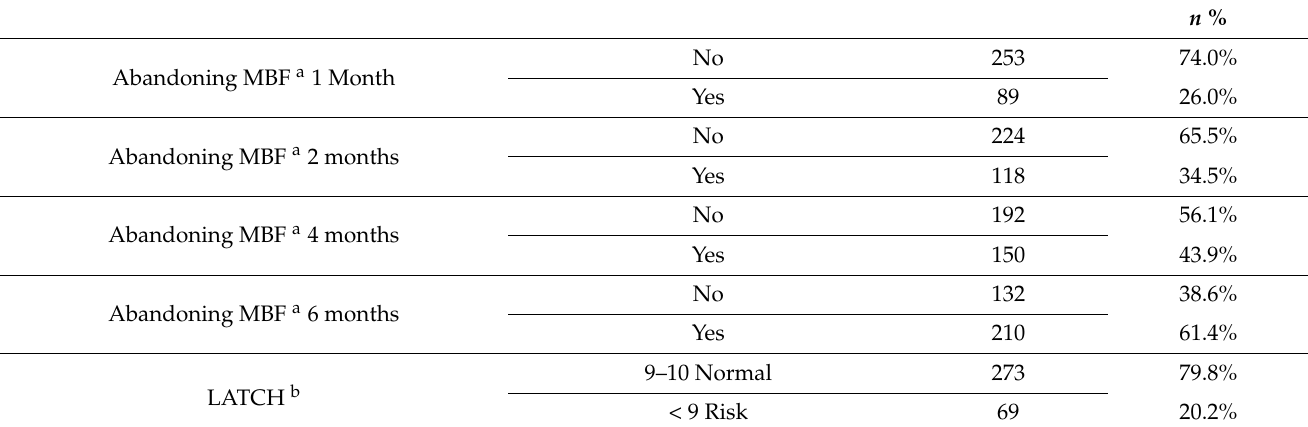
Table 1. The studied sample’s characteristics ( n =